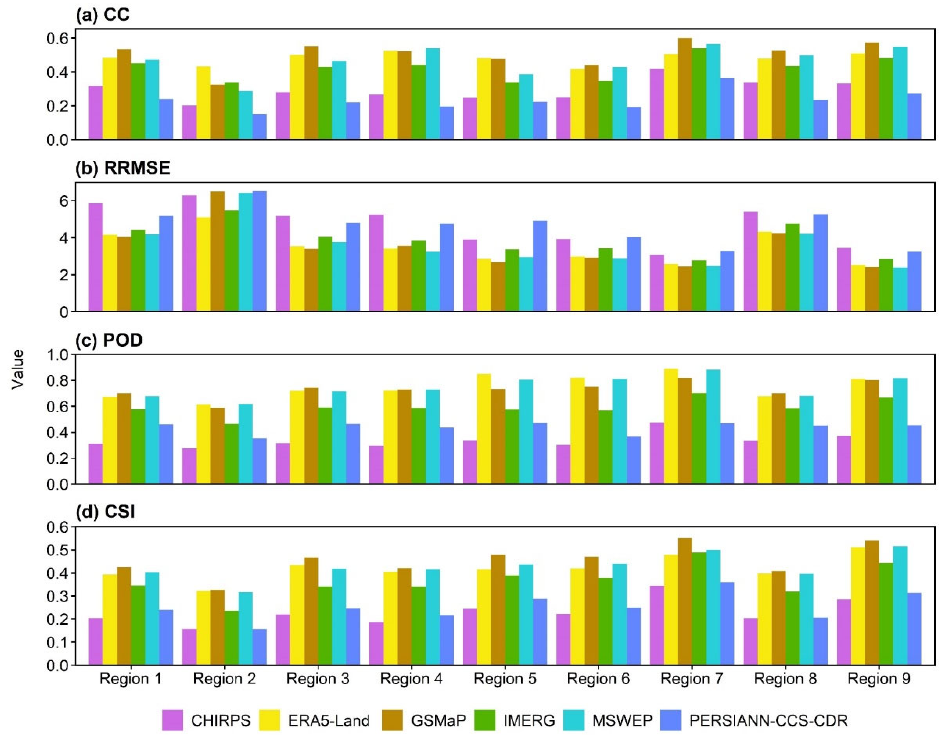
Figure 5. Mean values of ( a ) CC, ( b ) RRMSE, ( c ) POD and ( d ) CSI in the nine regions between 2015 and 2019.